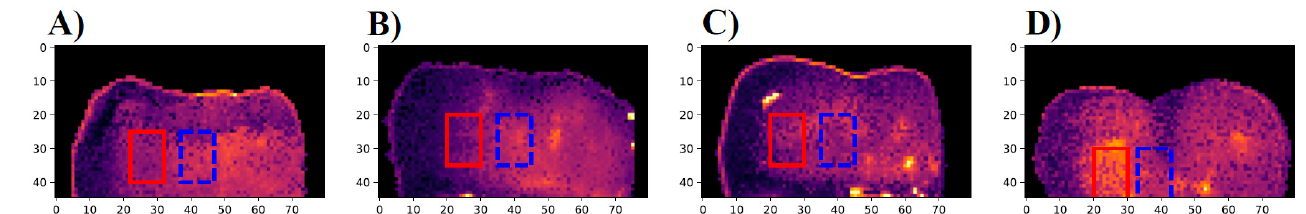
Figure 10. First slice of the eTC-PCT amplitude for samples ( A ) M2, 2 days of treatment, ( B ) M4, 4 days of treatment, ( C ) M6, 6 days of treatment, and ( D ) M8, 8 days of treatment. All images were acquired using a 0.2–0.6 Hz, 12 s chirp with 40 ms pulse widths, 63 W peak laser power and 20 ms slice widths for reconstructions. The red rectangle highlights the treatment region where the samples were exposed to the cariogenic biofilm. The dashed blue rectangle highlights the nearby sound region that was not exposed to the cariogenic biofilm. This region was used to determine a baseline sound enamel signal.